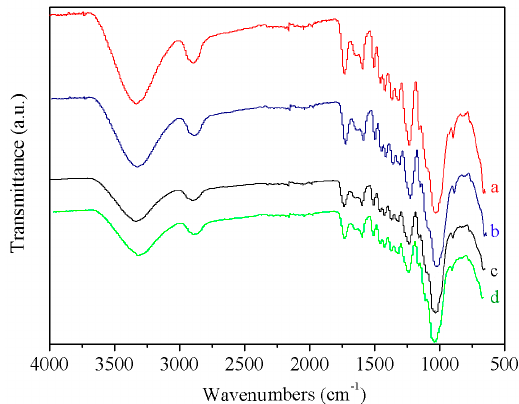
Figure 4. Comparison of the fourier transform infrared (FTIR) spectra obtained for untreated wood fibers and wood fibers modified through a high temperature and pressurized steam treatment under different conditions: ( a ) untreated fibers; ( b ) T = 120 °C, p = 0.2 MPa, t = 5 min; ( c ) T = 160 °C, p = 0.6 MPa, t = 15 min; and ( d ) T = 170 °C, p = 0.8 MPa, t = 5 min.